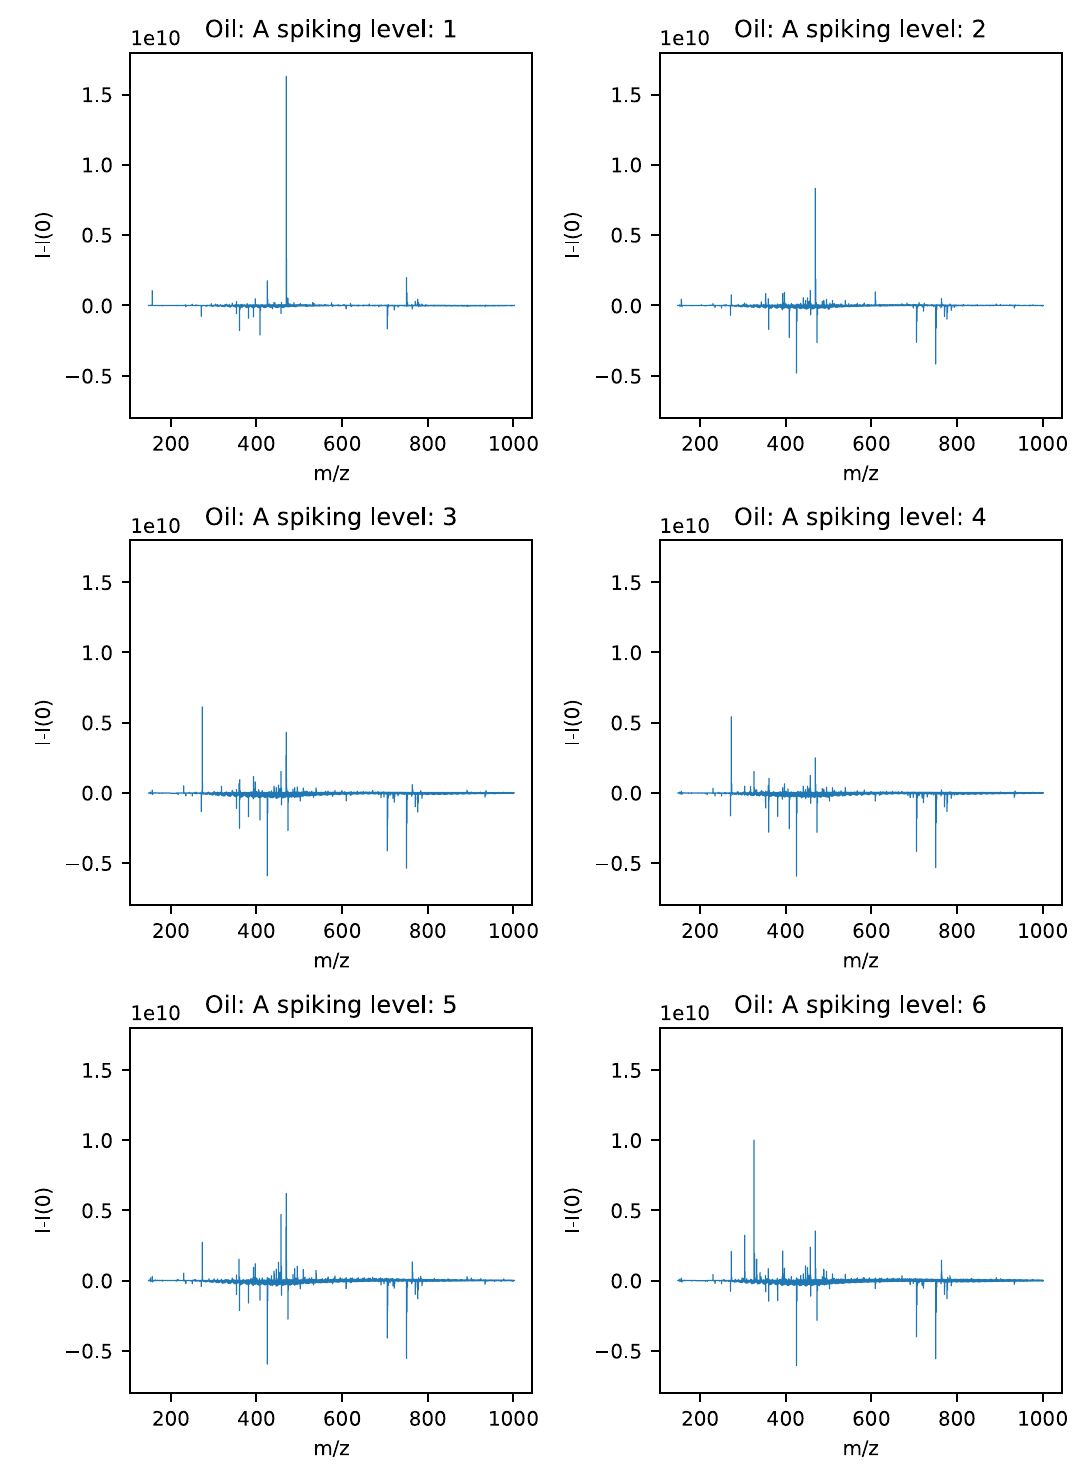
Fig 4. Mass spectra of samples from the hydrate phase for oil A with spiking level 0 subtracted from each of the spiking levels 1–6.